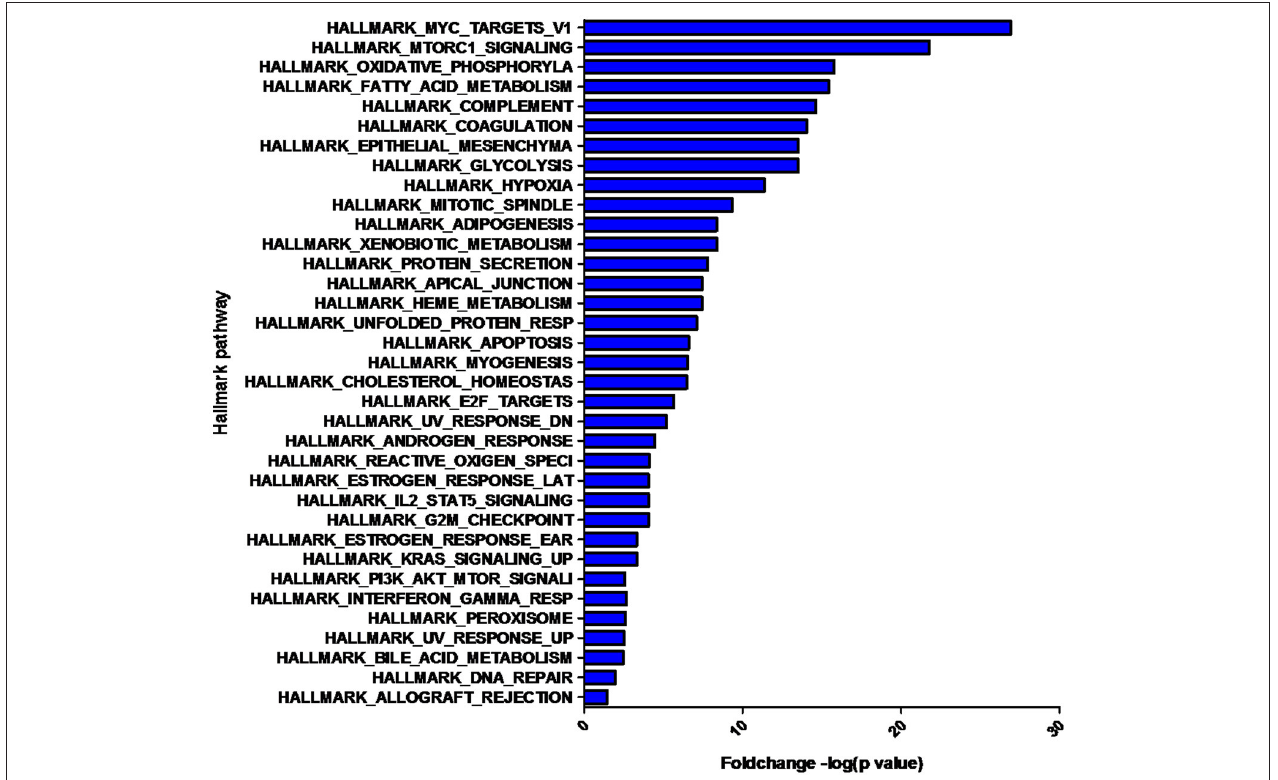
FIGURE 3 | Hallmark pathways enriched by the differentially expressed proteins. The significant pathways are displayed along the X-axis. The Y-axis displays the –log of the p